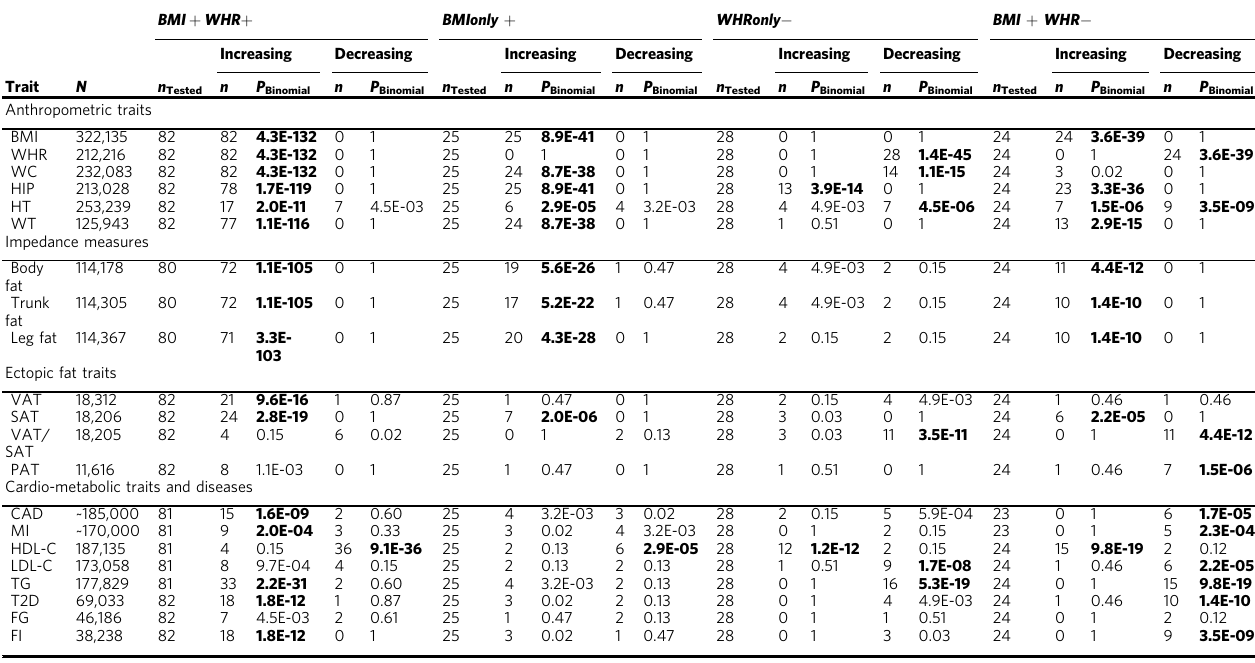
Table 1 Results of class-speci fi c enrichment analyses BMI + WHR + BMIonly + WHRonly − BMI + WHR − Increasing Decreasing Increasing Decreasing Increasing Decreasing Increasing Decreasing